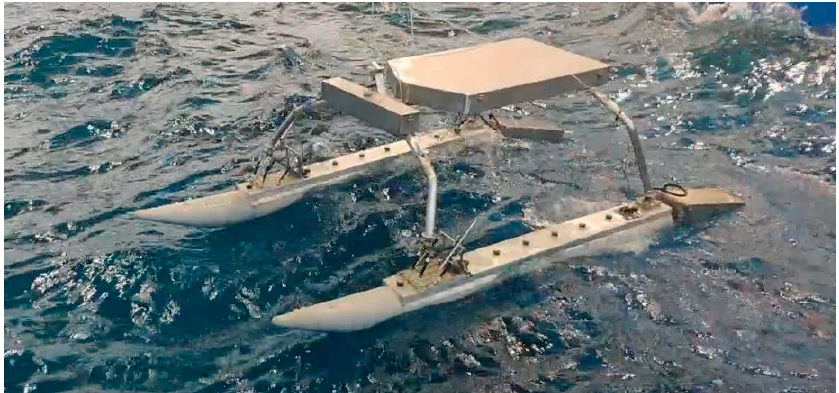
Figure 7. Photo of the rescue vessel during the experiment.